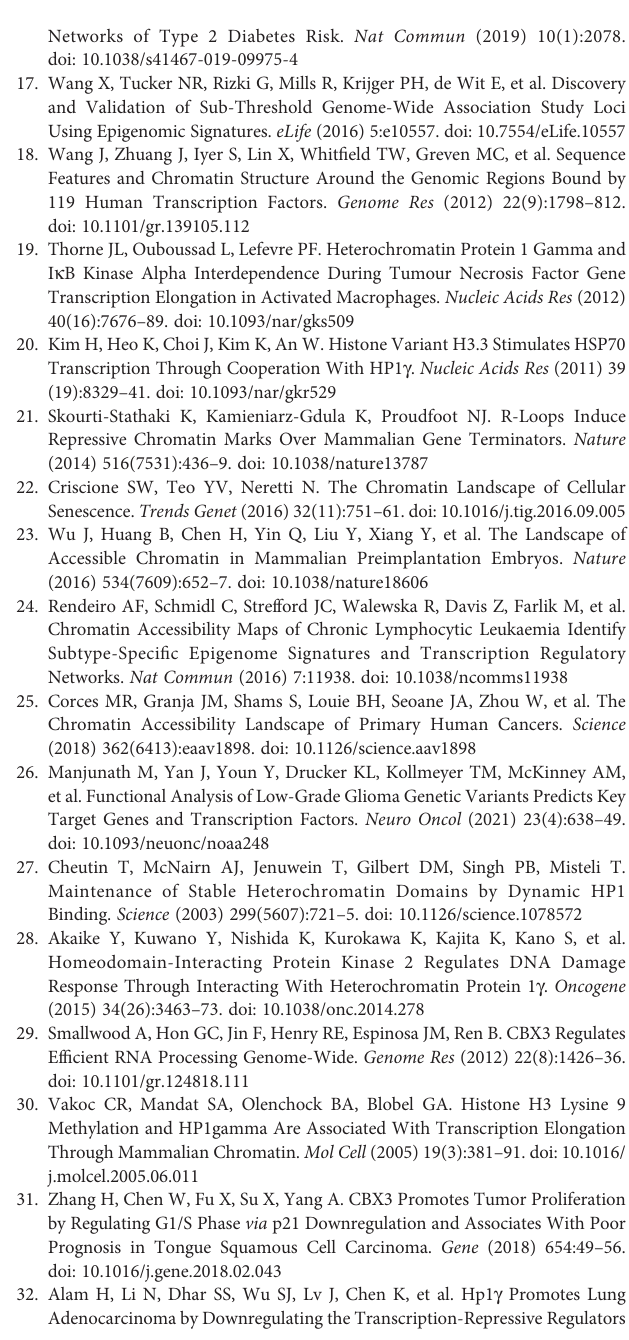
Supplementary Figure 1 | Flow chart of candidate SNPs selection. GWAS, genome-wide associationstudy; SNP,single-nucleotide polymorphism; LD, linkage disequilibrium; EAS, East Asian; ATAC-seq, assay for transposase-accessible chromatin using